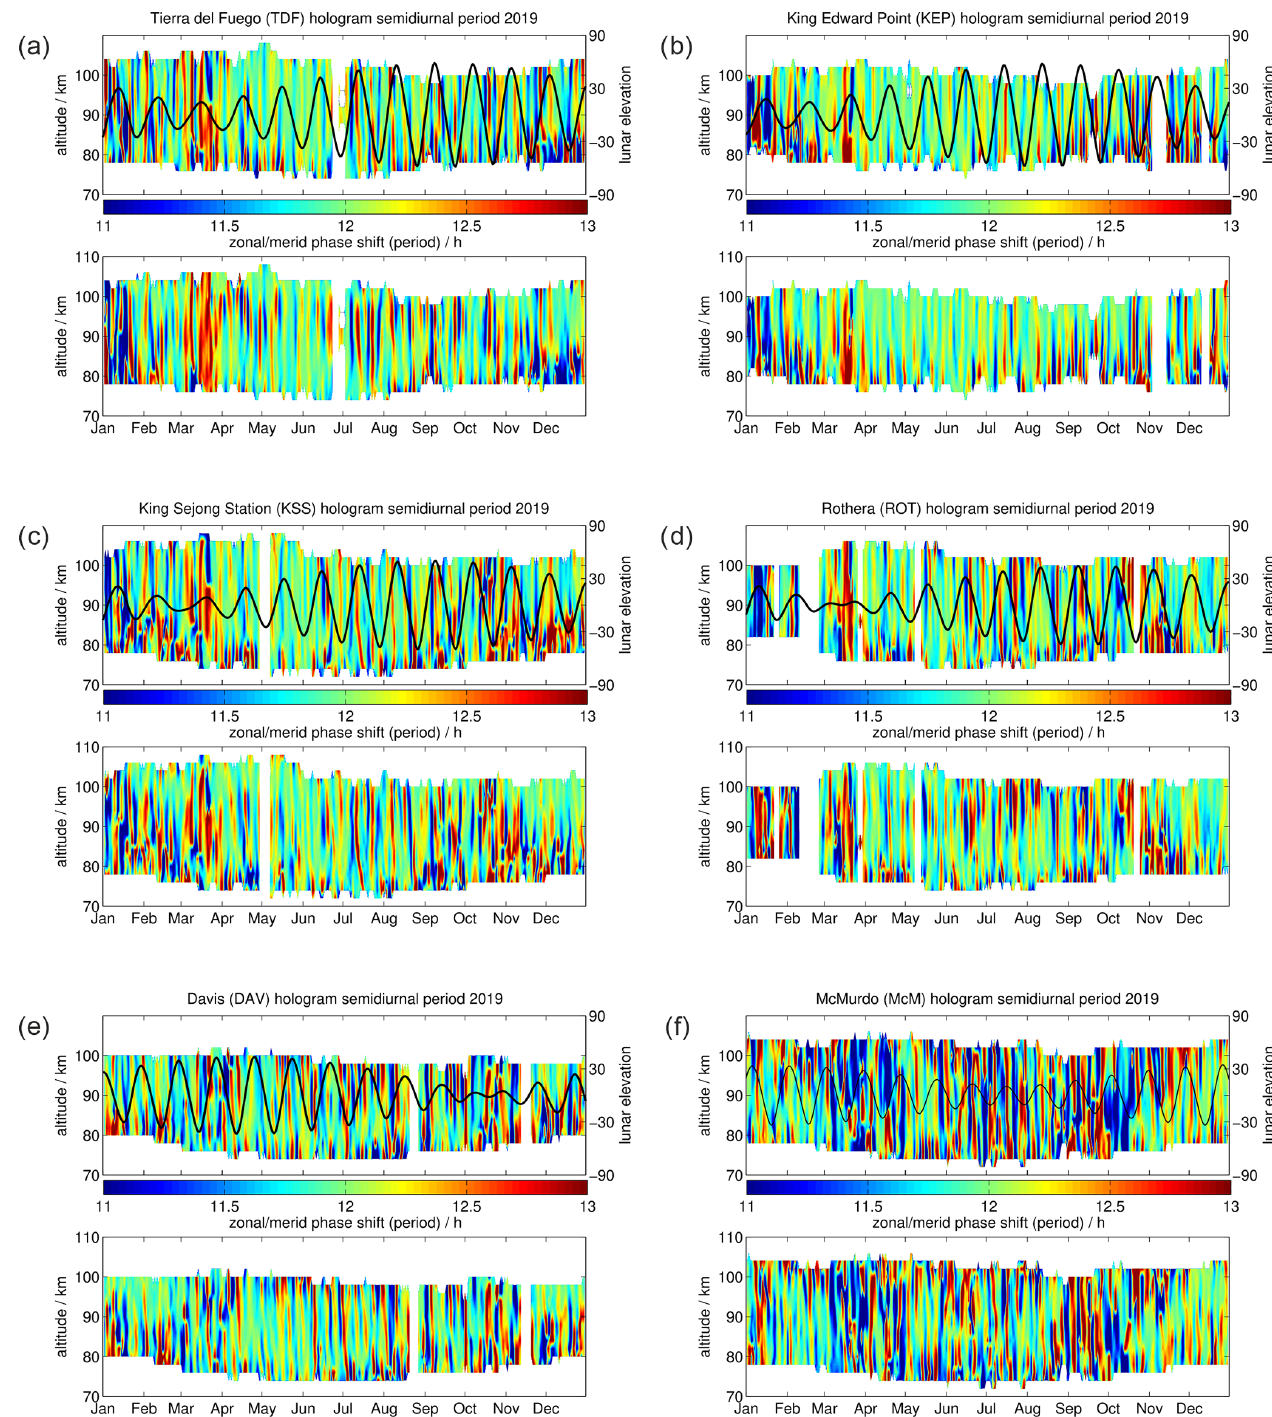
Figure A1. Holographic analysis of the semidiurnal tidal variability and lunar elevation angle (thin black line) for each station during the year 2019 for (a) TDF, (b) KEP, (c) KSS, (d) ROT, (e) DAV, and (f)